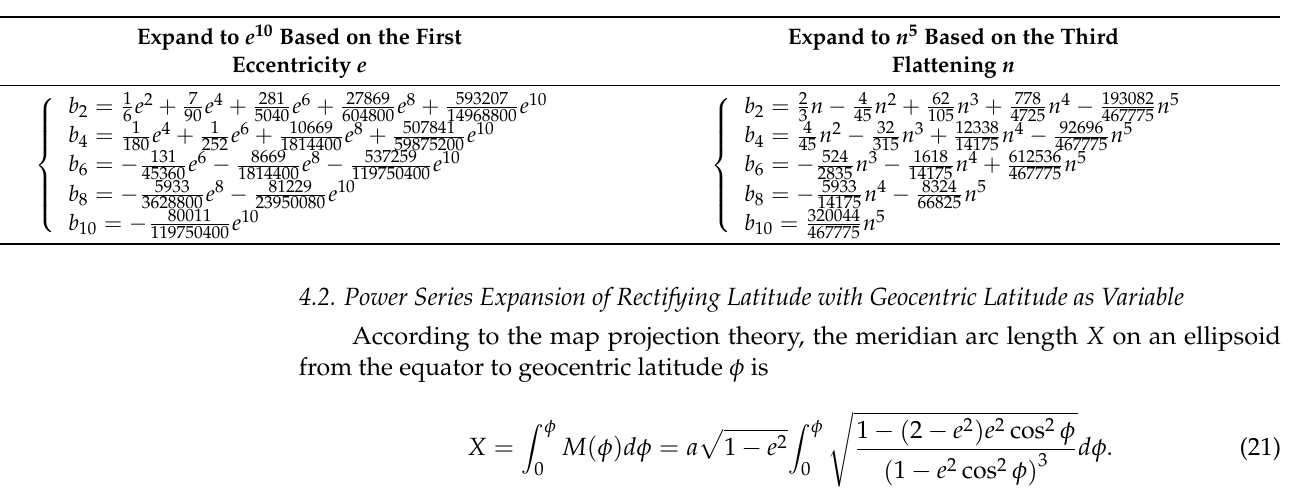
Table 6. Coefficients in Equation